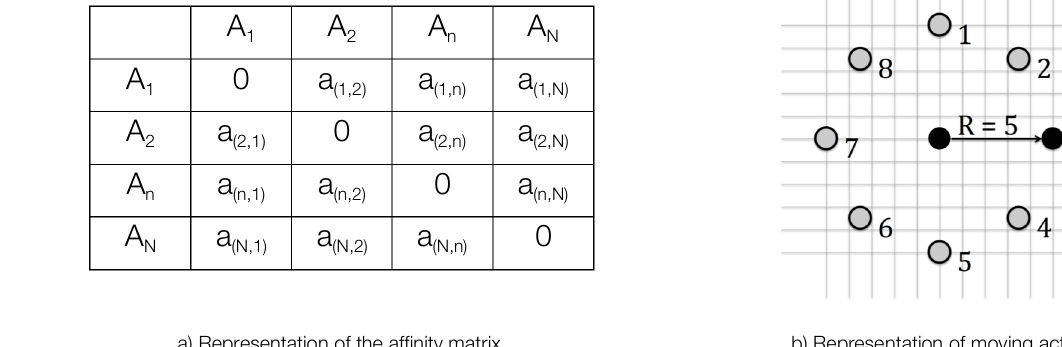
Figure 1 | Affinity matrix and moving